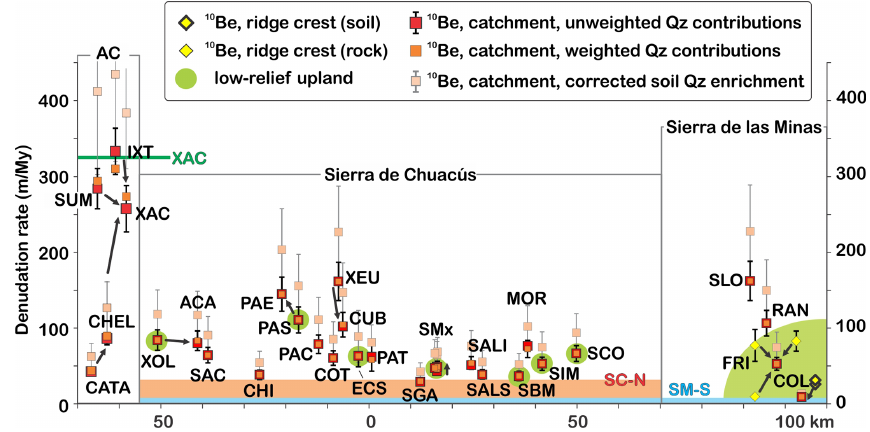
Figure 10. Variations in detrital 10 Be hillslope erosion rates along the strike of the plate boundary, from the AC range in the west, to the SM range in the east. Data are projected along the strike of the plate boundary, on an arc displayed on Fig. 6. Arrows show a feeding relationship between nested hillslope sites and catchments. Some uplands drain remnants of the middle Miocene Maya surface (green shaded areas). Detrital 10 Be hillslope erosion rates are compared to river incision rates along the northern (salmon-colored shaded area, SC-N) and southern (blue-shaded area, SM-S) base of the SC-SM range over the past 7Myr. XAC shows the peak incision rates in the AC range along Río Xacbal, below the Maya surface (Fig.